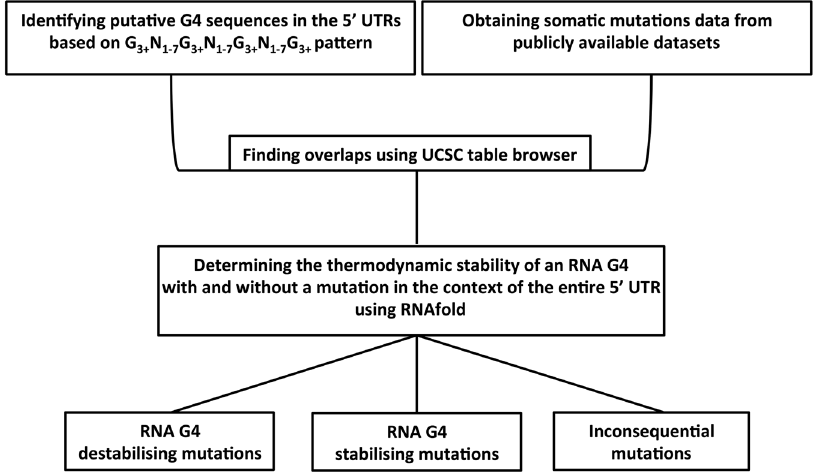
Figure 1. Flowchart illustrating the procedure for identifying mutations that change predicted RNA G4 stability in the 5 ′ UTRs of genes mutated in